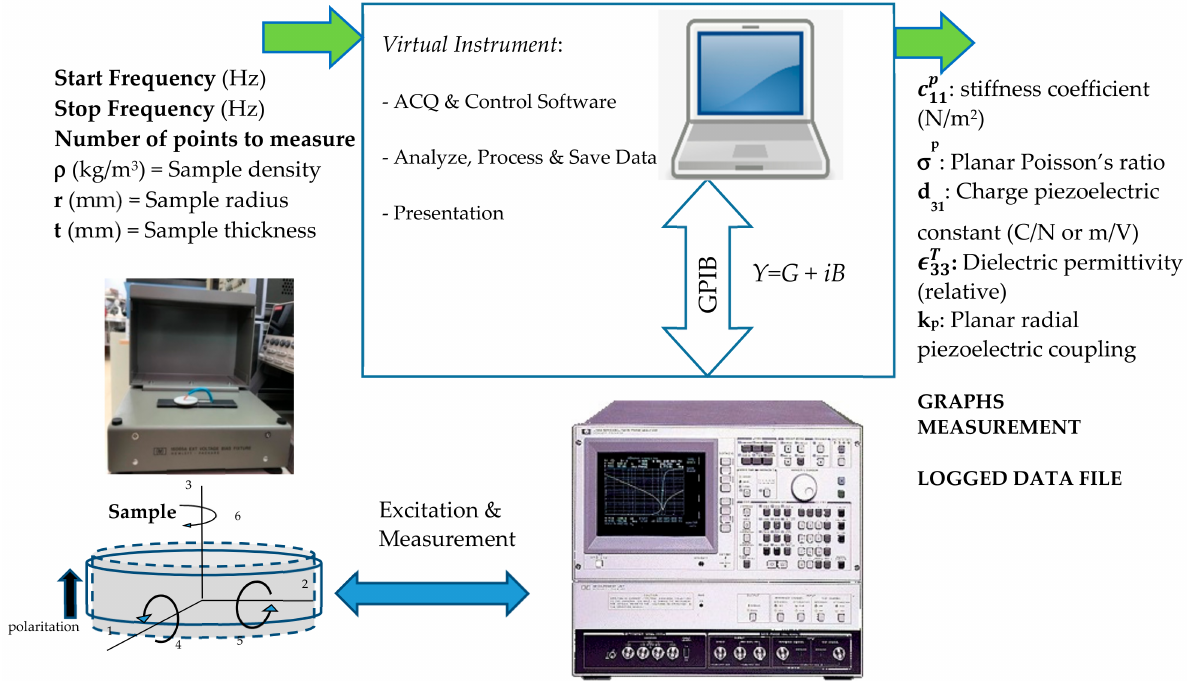
Figure 3. Block diagram of the proposed measurement